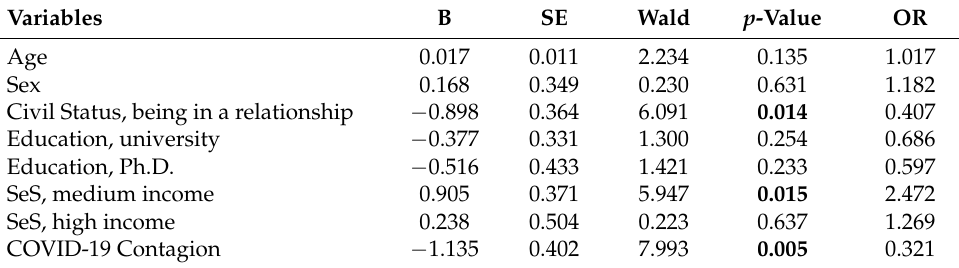
Table 2. Results from the multiple hierarchical logistic regression on vaccine hesitancy (favorable, n = 928; hesitant, n = 136); significant p -values are reported in